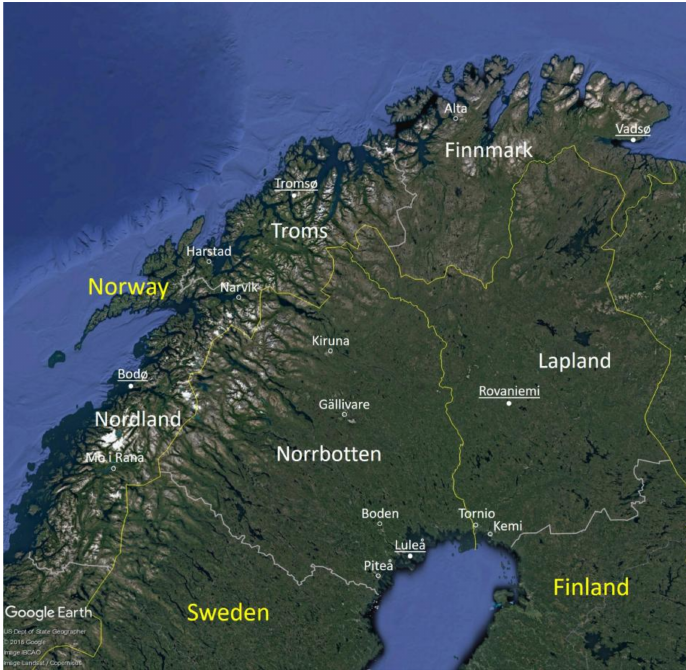
Figure 1. Map including the northern counties of Finland (“Lapland”), Norway (“Finnmark”, “Troms” and “Nordland”) and Sweden (“Norrbotten”) and cities of the counties with a population >10,000. ( • Administrative centre; ◦ city). Source: Google Earth. US Dept of State Geographer © Google Earth. Image IBCAO. Image Landsat/Copernicus. Adapted by